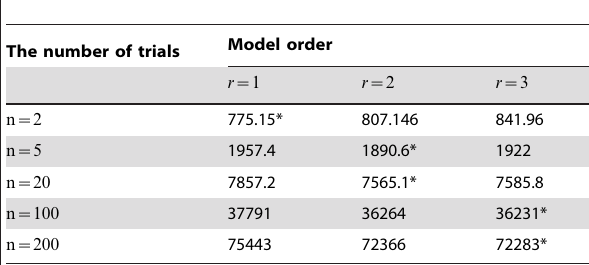
Table 2. AICs for different numbers of